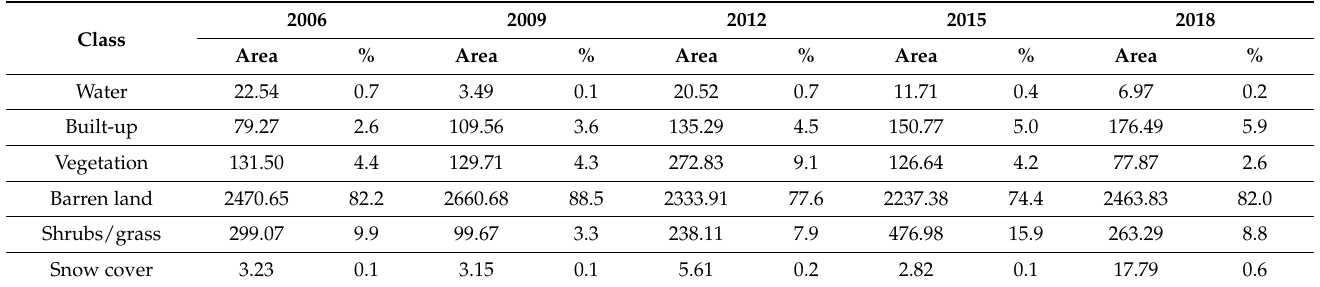
Table 2. Land cover classes in area (km 2 ) and % obtained from LC classification for dry season.